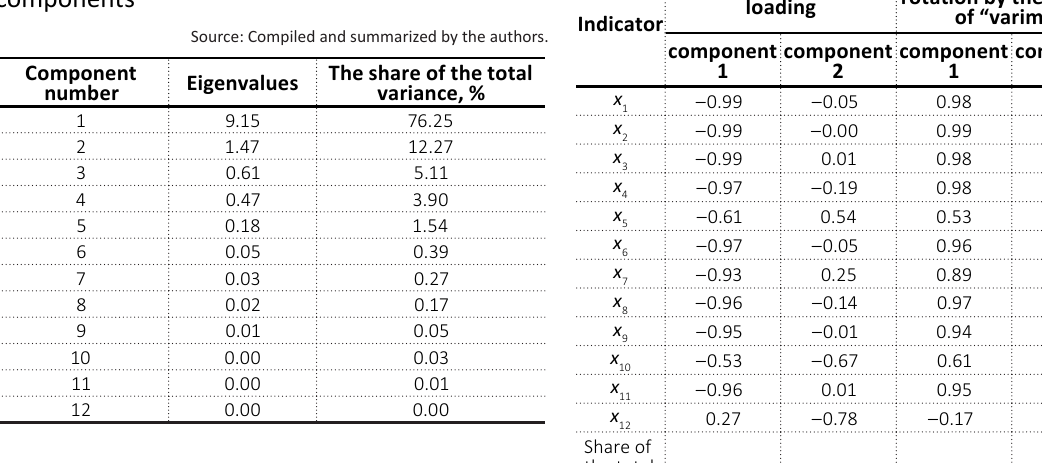
Table 5. Eigenvalues and the total variance of components